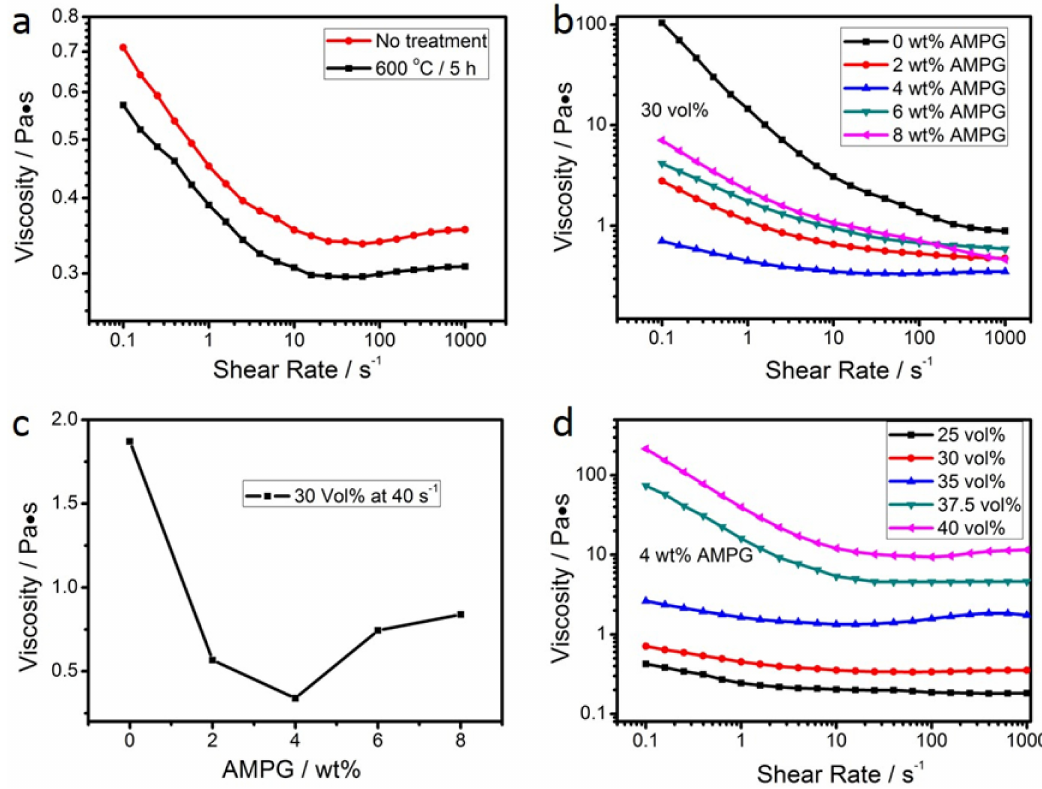
Figure 2. Influence of ( a ) the heat treatment of Si powder, ( b ) the amount of dispersant, and ( d ) the solid-loading on the viscosity measured at a shear rate from 0.1 up to 1000 s − 1 , and ( c ) the influence of the amount of dispersant in the suspensions on the viscosity from ( b ) at a shear rate of 40 s − 1 . ( a ) suspension with different heat treatments of Si powder, original or heat-treated at 600 ◦ C for 5 h, with 30 vol % solid-loading and 4 wt % dispersant. ( b , c ): suspensions with heat-treated Si powder with 30 vol % solid-loading. ( d ) suspensions with heat-treated Si powder with 4 wt %